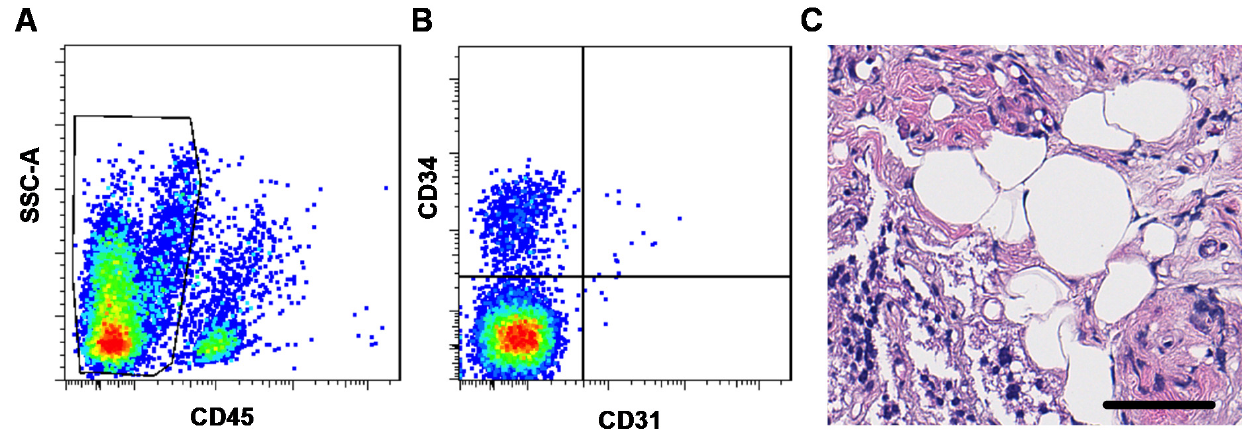
Figure 3. ( A , B ) Flow cytometry and ( C ) HE staining of mSVF cells. ( A ) and ( B ) Freshly isolated and processed mSVF cells underwent flow cytometry staining for the hematopoietic marker CD45, the endothelial marker CD31 and the mesenchymal stromal cell marker CD34. ASCs were defined